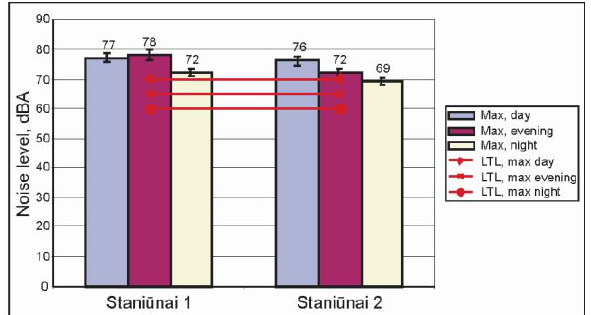
Fig. 25. Dynamics of maximum noise levels in Staniūnai street within twenty four hours